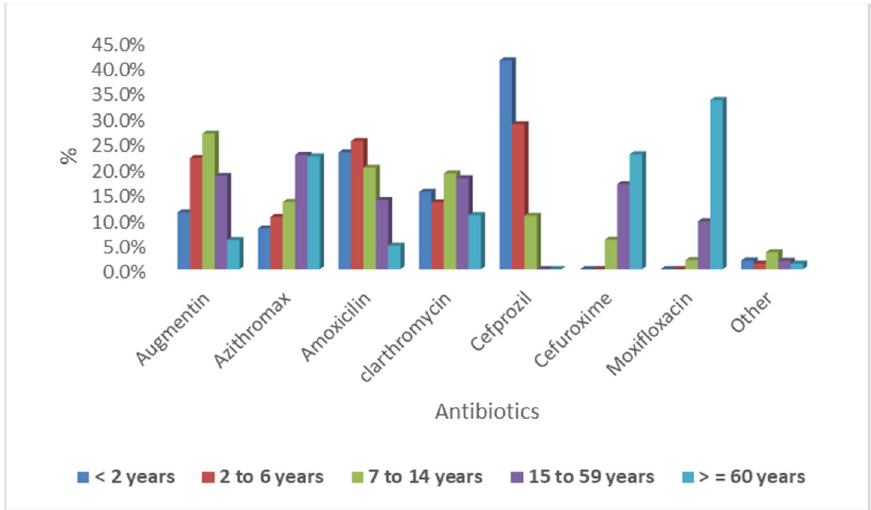
Figure 2 . Distribution of antibiotics prescribed by age category. Figure 2. Distribution of antibiotics prescribed by age